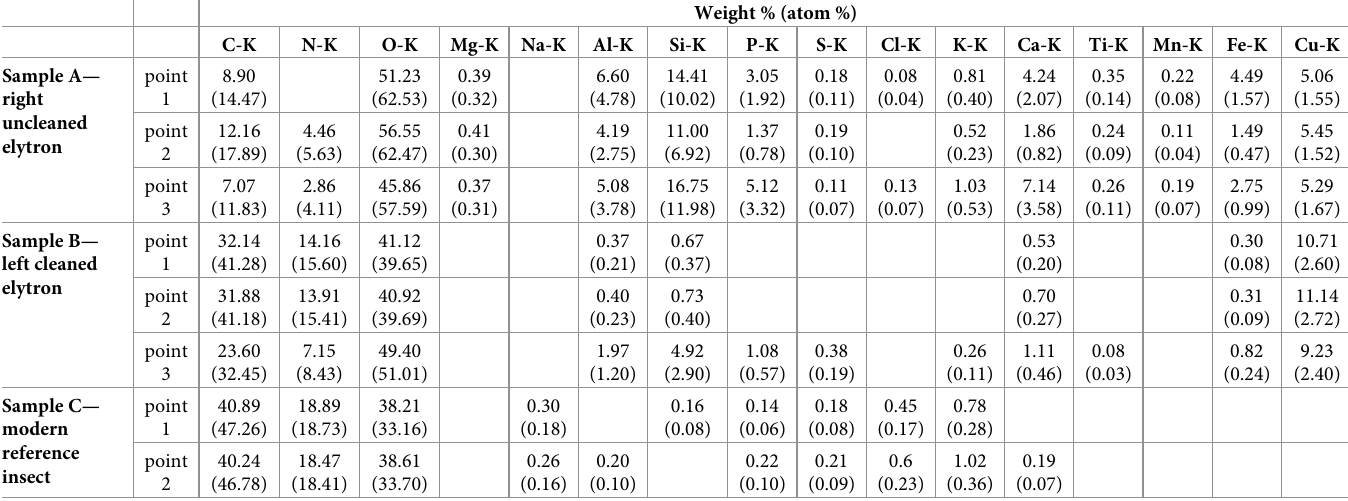
Table 2. The results of the SEM-EDS elemental composition analysis measured at individual points on samples A and B (remains of Geotrupes stercorarius from the urn from burial 506) and sample C (modern Geotrupes Stercorarius ). The measurement points for each sample correspond to the individual plots shown in Fig